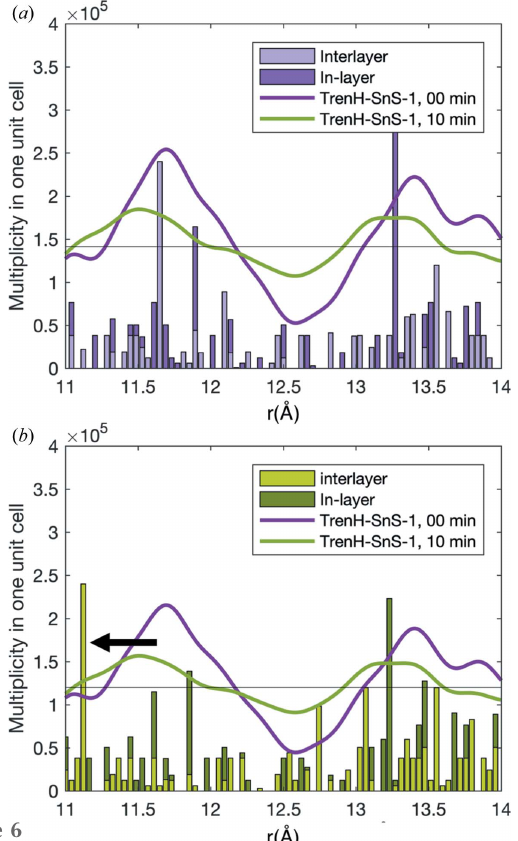
Figure 6 Solid lines are the experimental PDF data of pristine (purple) and water- treated (green) trenH-SnS-1 [same data in ( a ) and ( b )]. Histograms representing pair correlations (11–14 A ˚ ) resulting from the refinement of the PDFs of trenH-SnS-1 in water at ( a ) 0 min (pristine) and ( b ) 10 min. The histograms represent the number of interatomic distances (weighted by the scattering power of the atoms in the pair) according to the refined models. The correlations have been divided into intralayer/in-layer (dark purple or dark green) and interlayer (light purple or light green) correlations. The apparent downwards shift of the strong scattering interlayer correlations at 11.7 A˚ in ( a ) to 11.2 A˚ in ( b ) are highlighted with an